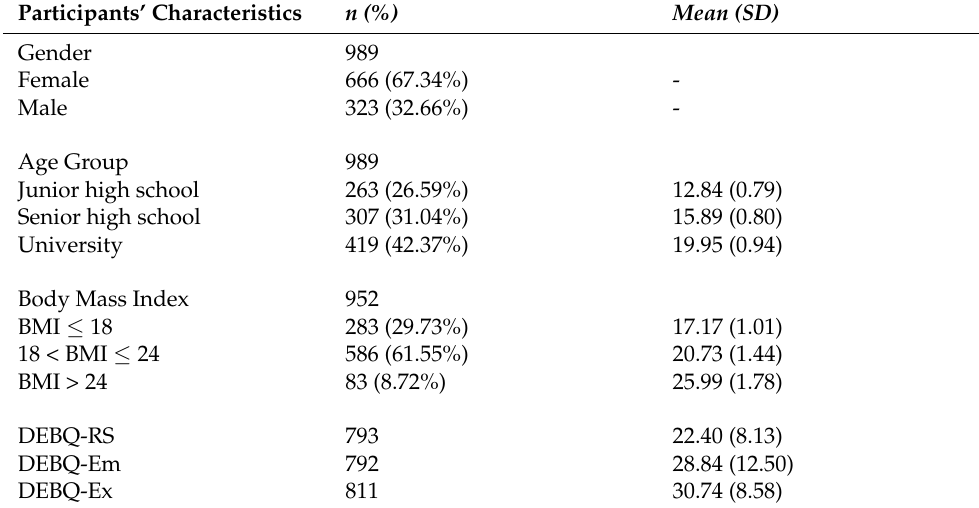
Table 1. Demographic characteristics of the